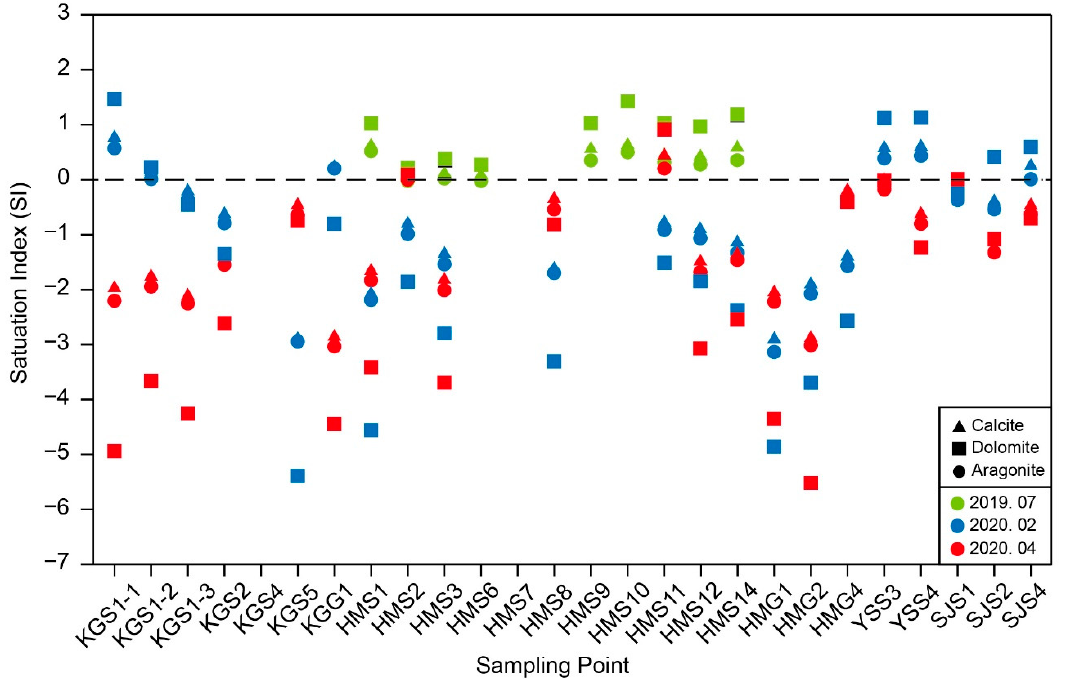
Figure 6. Saturation index (SI) for relative carbonate minerals (aragonite, calcite, and dolomite) by seasonal variations.